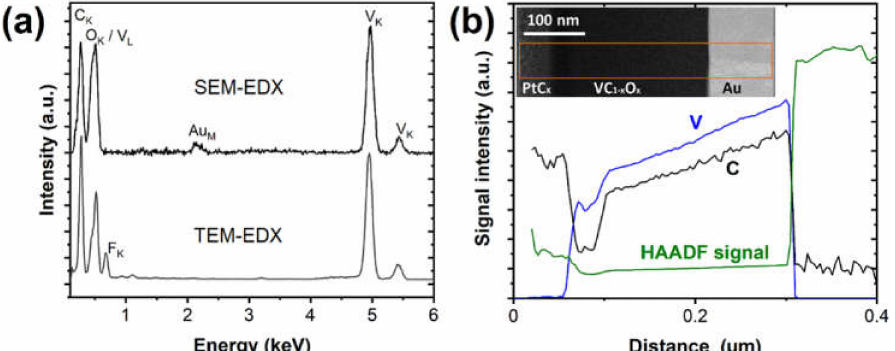
Figure 4. ( a ) Comparison of EDX spectra obtained in the SEM and TEM equipment used for analysis. F in the TEM sample is a residue of the lamella preparation and often observed in the samples. ( b ) EELS line scans for C and V L show a similar trace with increasing thickness of the TEM lamella towards the Au substrate material. The scan is carried out along the line indicated in the HAADF image with contributions of a PtC x FEBID protection layer, FEBID VC 1 − x O x , and the Au substrate.